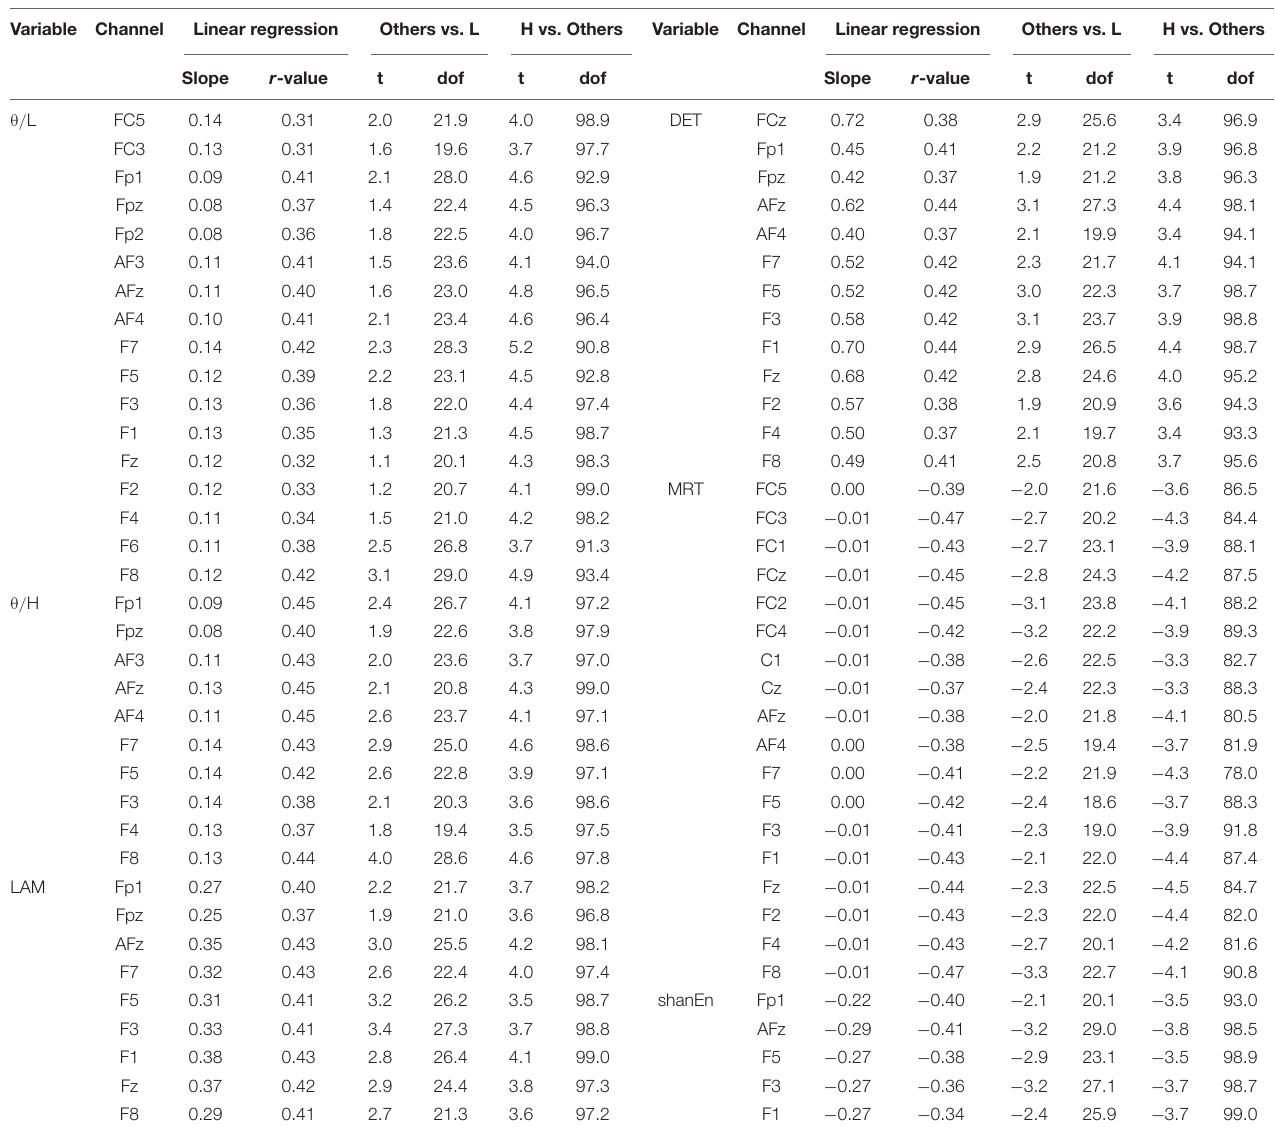
TABLE 1 | Significant results of the linear relationship between the prior EEG features in the REO condition and the subsequent BCI performance (p < 0.01, Bonferroni-adjusted p-values; L, H in table are the abbreviations of low-performance and high-performance group, respectively). Variable Channel Linear regression Others vs. L H vs. Others Variable Channel Linear regression Others vs. L H vs.